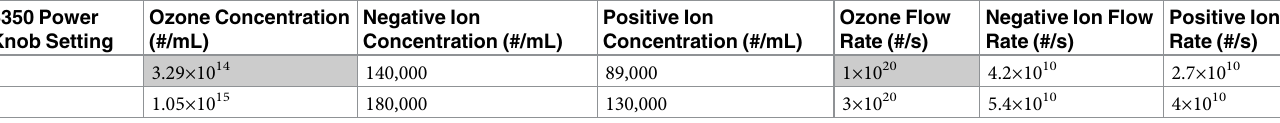
Table 3. Downstream ion concentration in 620 cfm (0.3 m 3 /s) flow ambient air (24.5˚C,